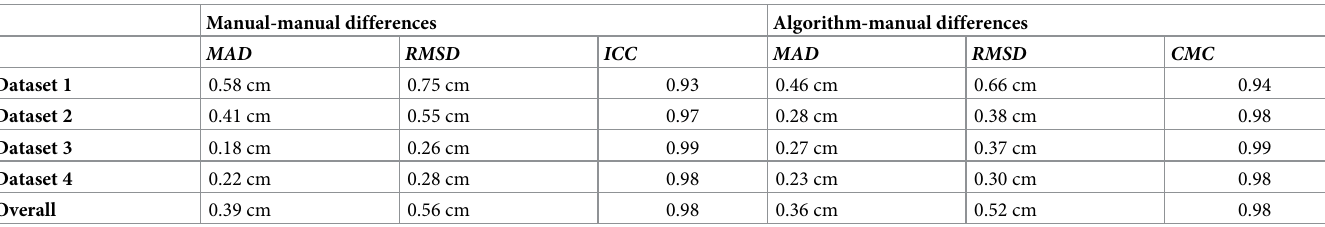
Table 3. Fascicle length. Manual-manual differences Algorithm-manual